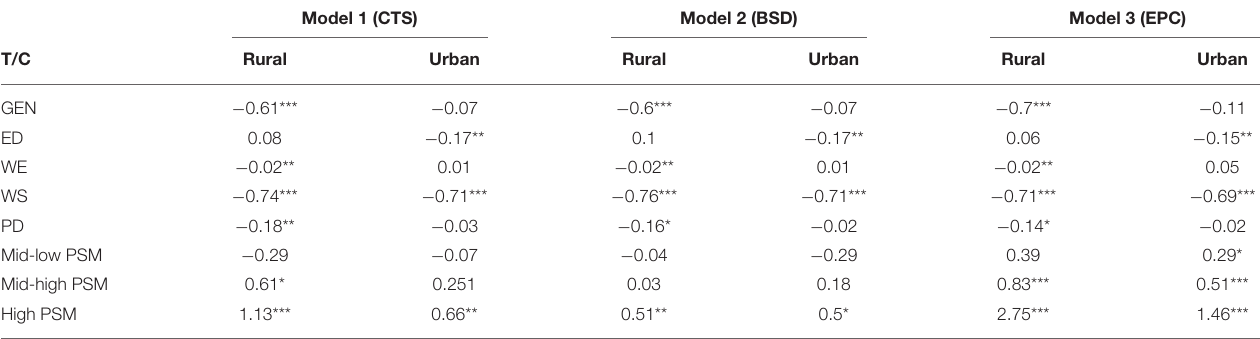
TABLE 4 | Impact coefficient and urban-rural